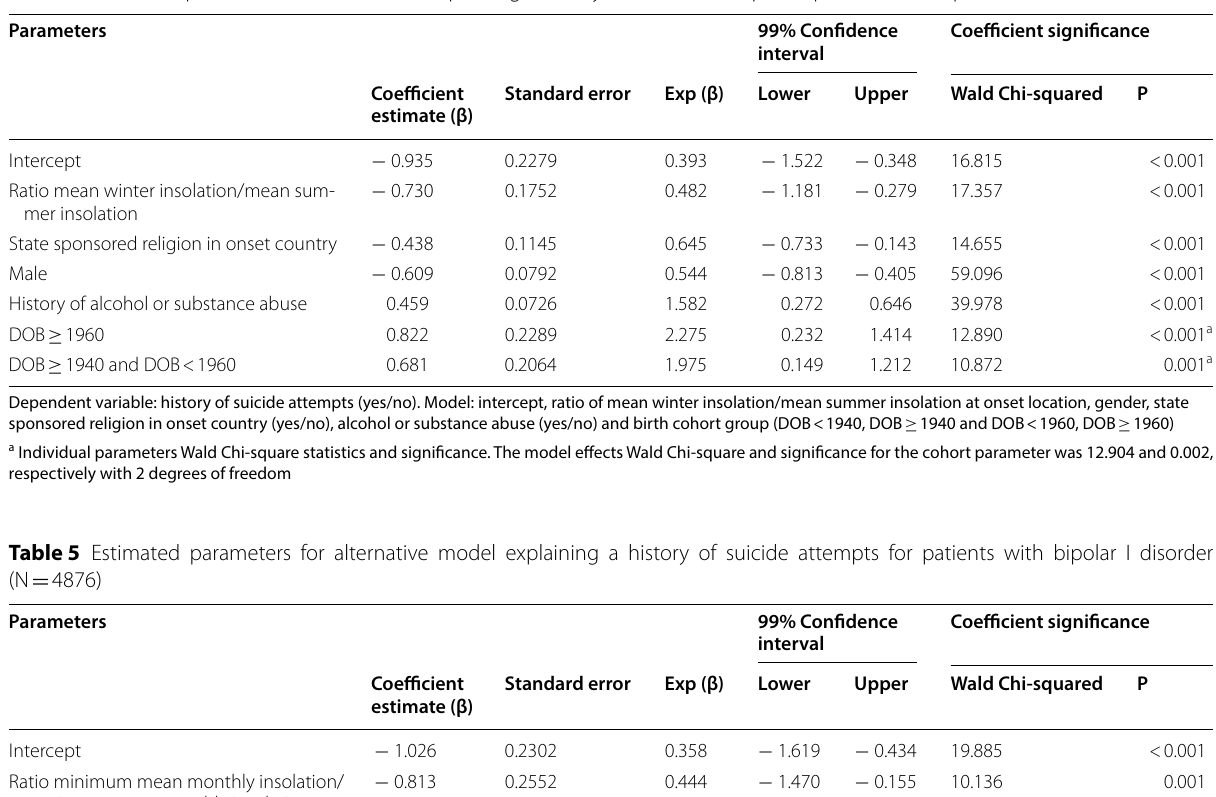
Table 4 Estimated parameters for best model explaining a history of suicide attempts for patients with bipolar I disorder (N